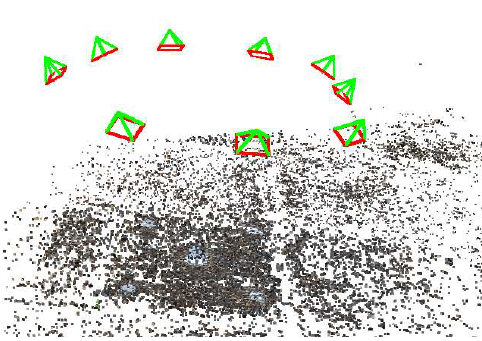
Figure 7: Images acquired around the GPS receiver The estimated camera poses from bundle block adjustment